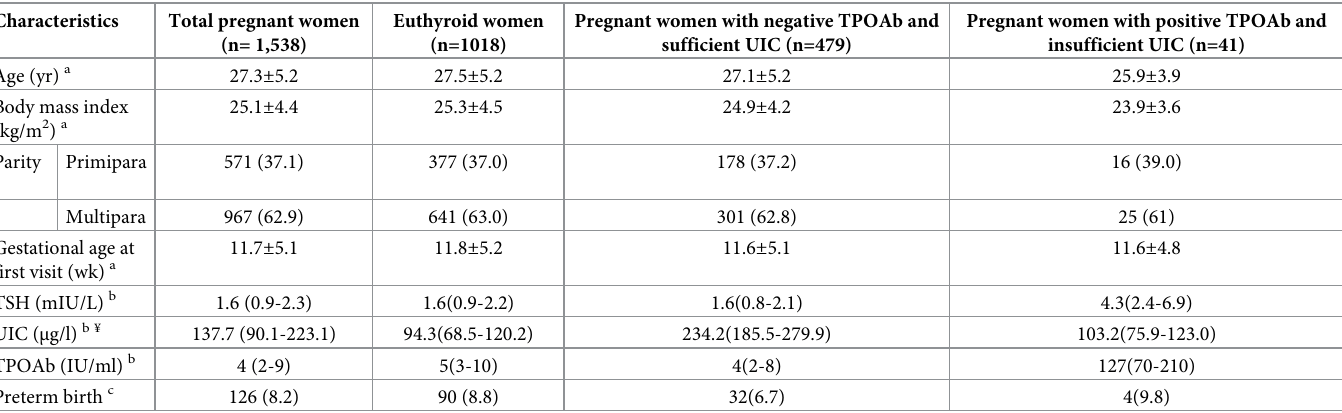
Table 1. Characteristics of the study participants.